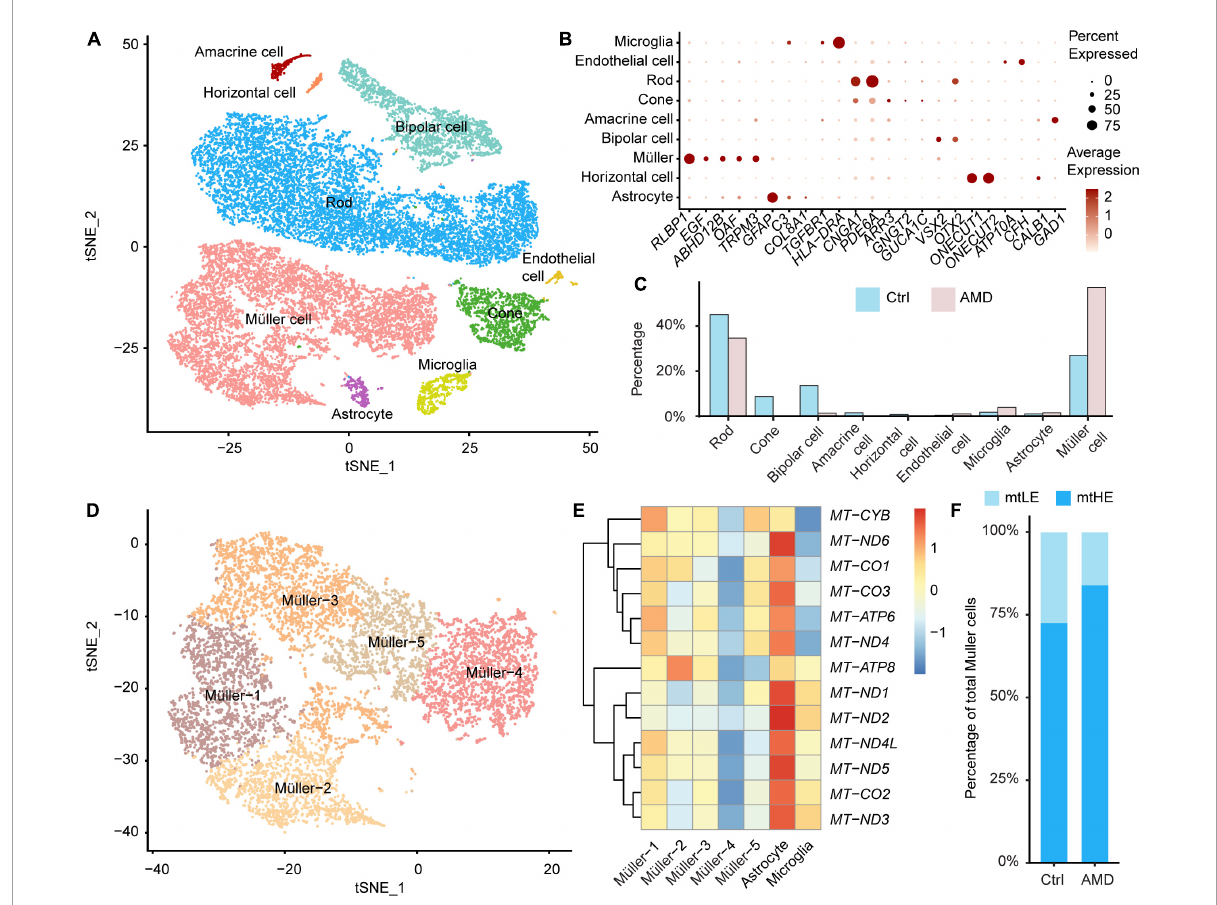
FIGURE1 Single-cell transcriptomes of the human retina suggest the heterogeneity of Müller cells. (A) A total of nine neuronal and glial clusters in the human retina were identified and visualized by t-distributed Stochastic Neighbourhood Embedding (tSNE) dimensionality reduction. (B) The expressions of key marker genes help determine the cellular identification of each cluster. (C) The abundance of each cluster in samples from age-related macular degeneration (AMD) or healthy donors is different. (D) Müller cells are further divided into five subpopulations by unsupervised clustering. (E) The distinct glial cells residing in retinas have different expression profiles of mitochondrial encoded genes. The Müller-4 subcluster is marked as low expression of mtDNA (mtLE) cells. (F) The abundance of mtLE Müller cells is reduced in the AMD